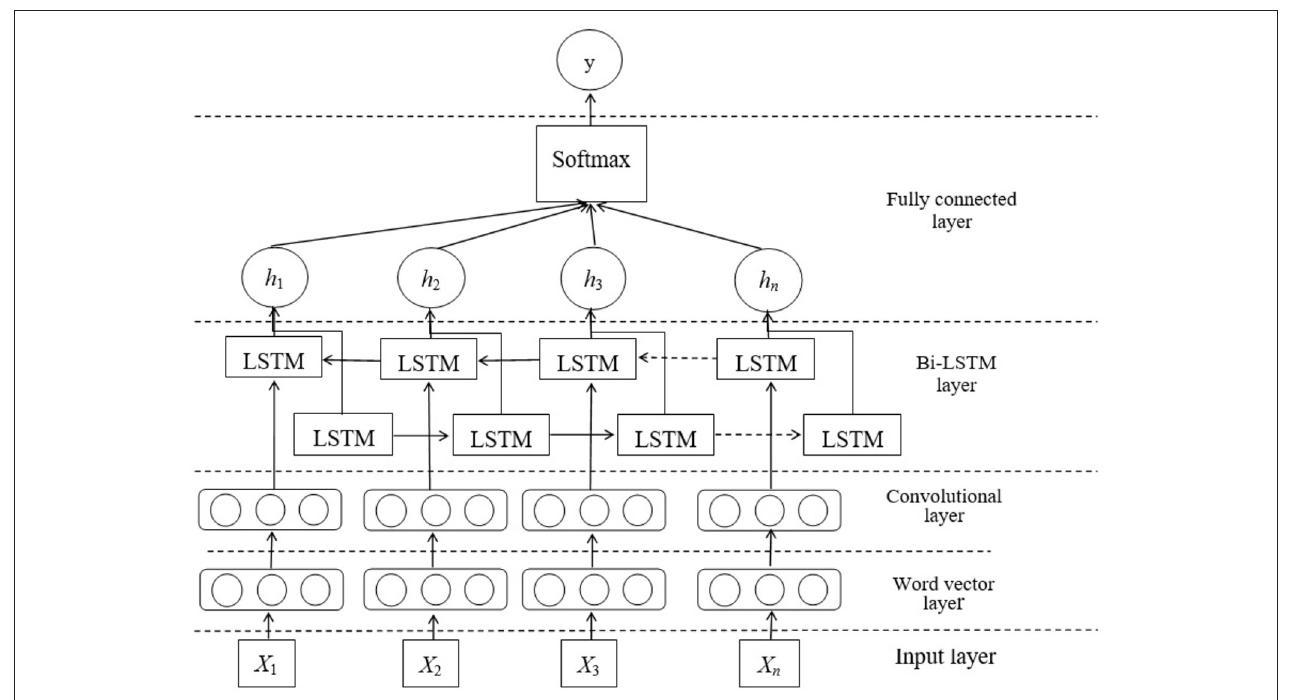
FIGURE 3 | The network model of emotion analysis based on Bi-LSTM and CNN.